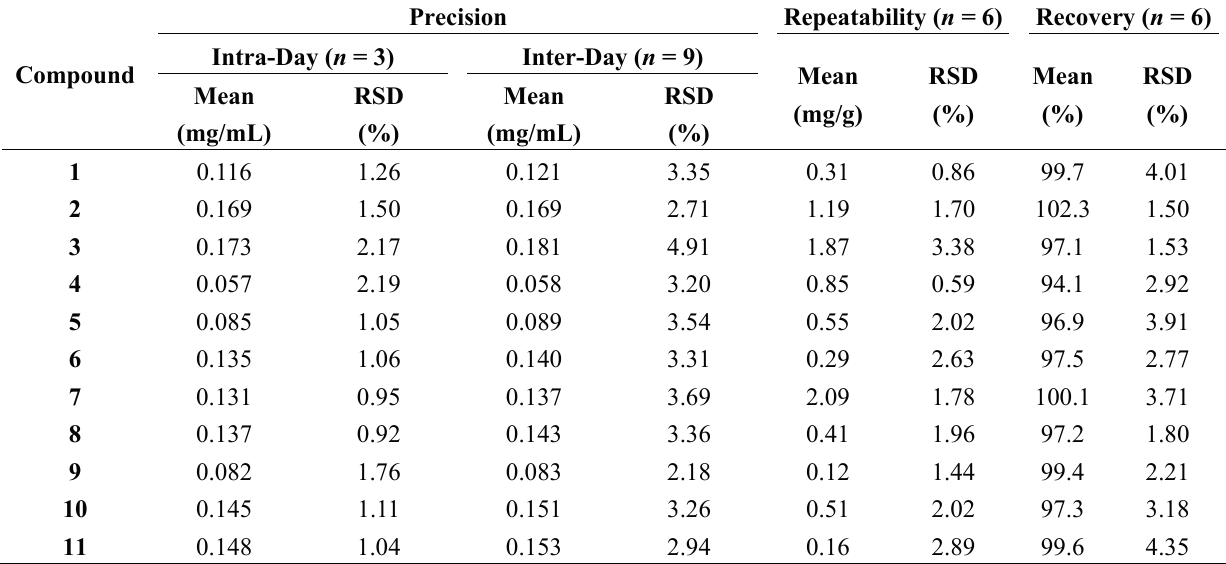
Table 3. Precision, repeatability and recovery data for alkaloids of Corydalis Rhizoma.